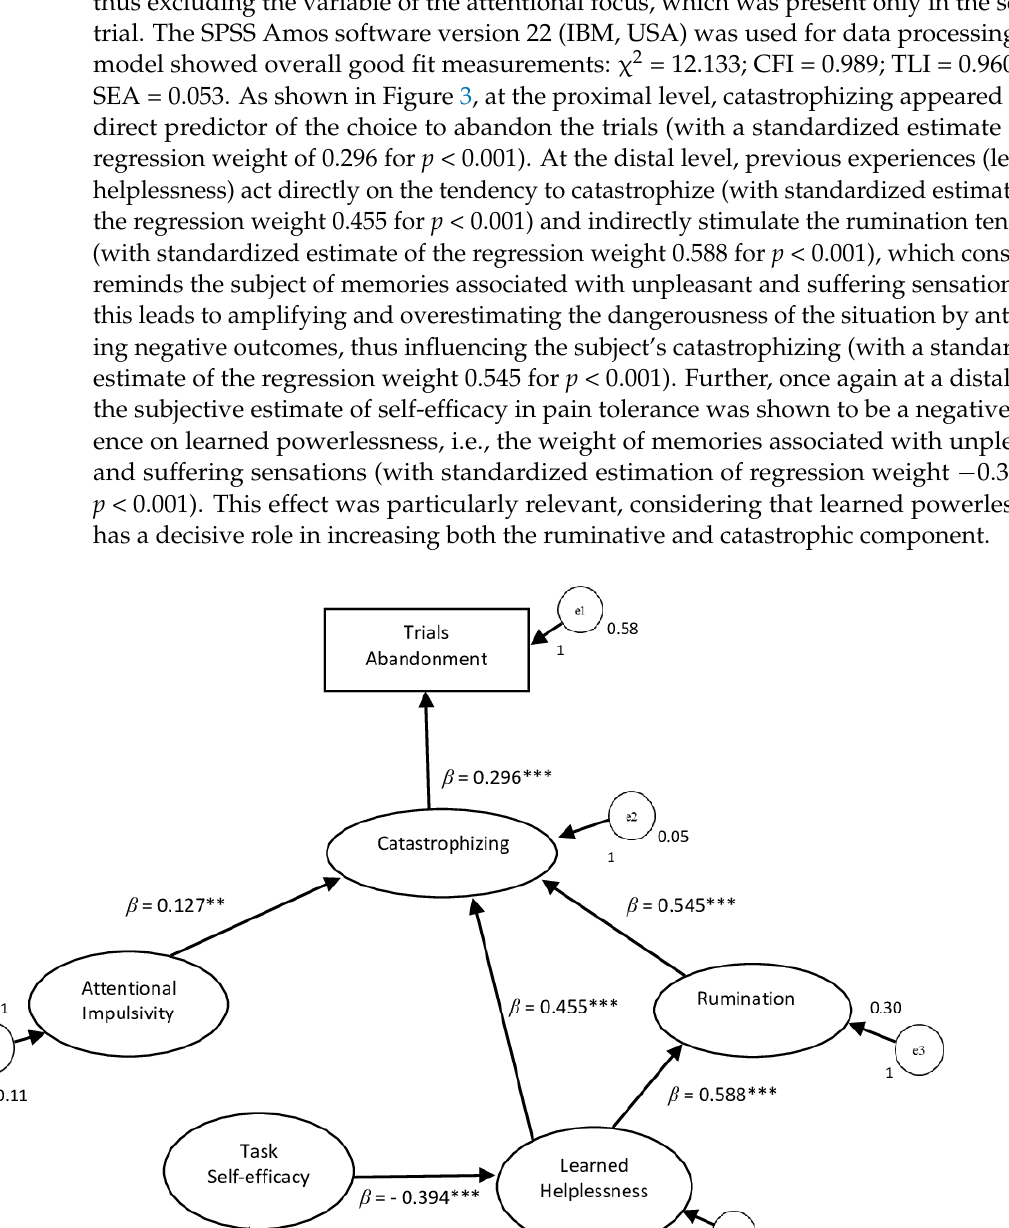
Figure 3. Path model.